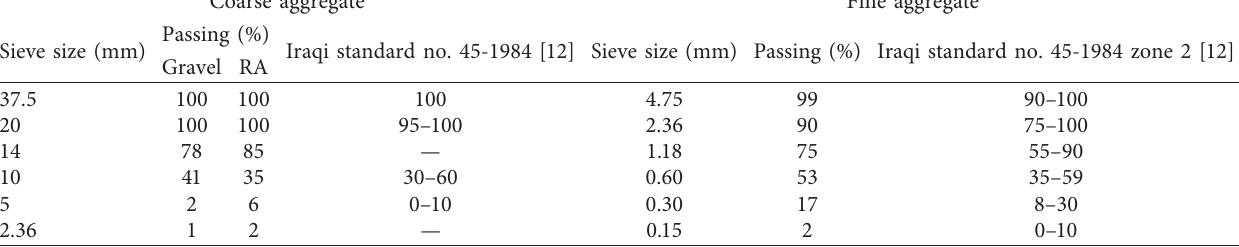
Table 3: Grading of fine and coarse aggregate.